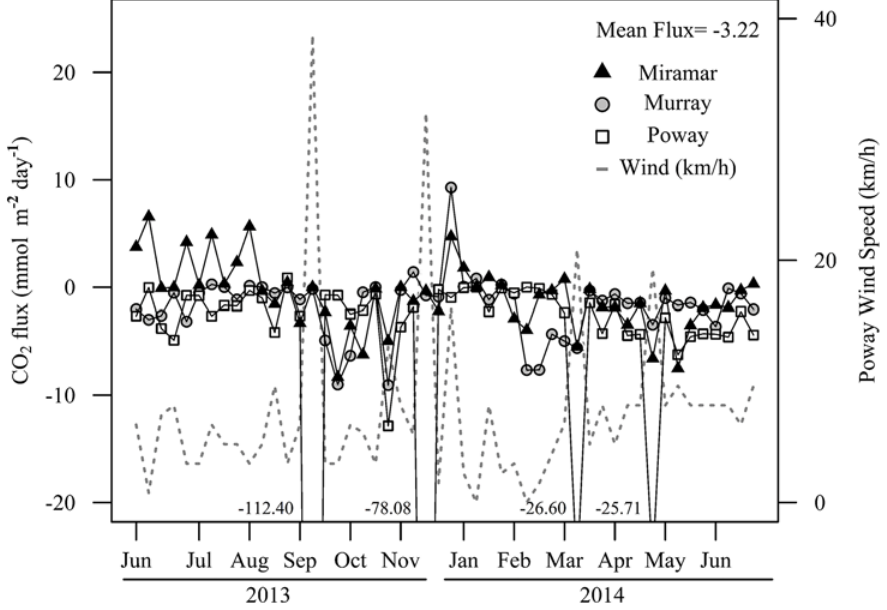
Fig 4. Time series of estimated CO2 flux (mmol m -2 day -1 ). The four negative values correspond to CO 2 flux in Lake Poway that were below the range of the graph during strong wind events.